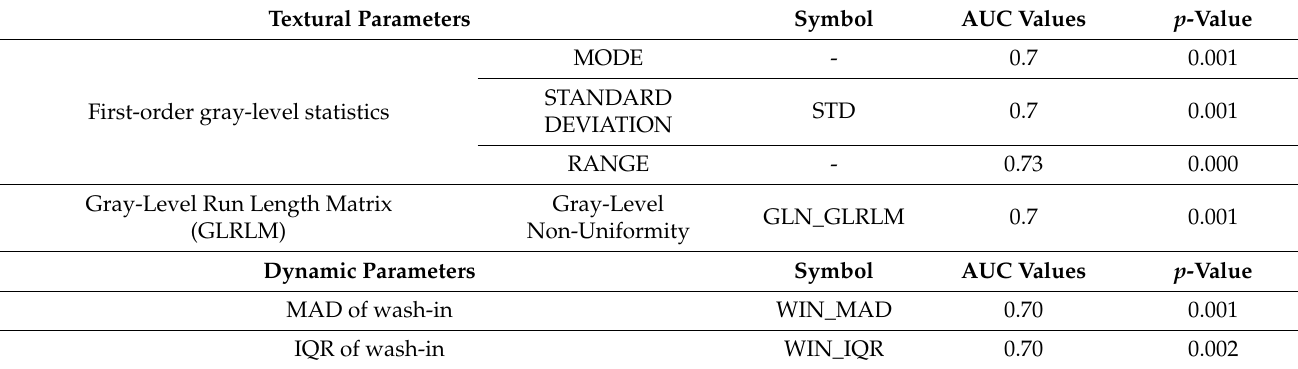
Table 5. List of significant textural and dynamic features with the corresponding area under curve (AUC) and p -values. Textural Parameters Symbol AUC Values p -Value